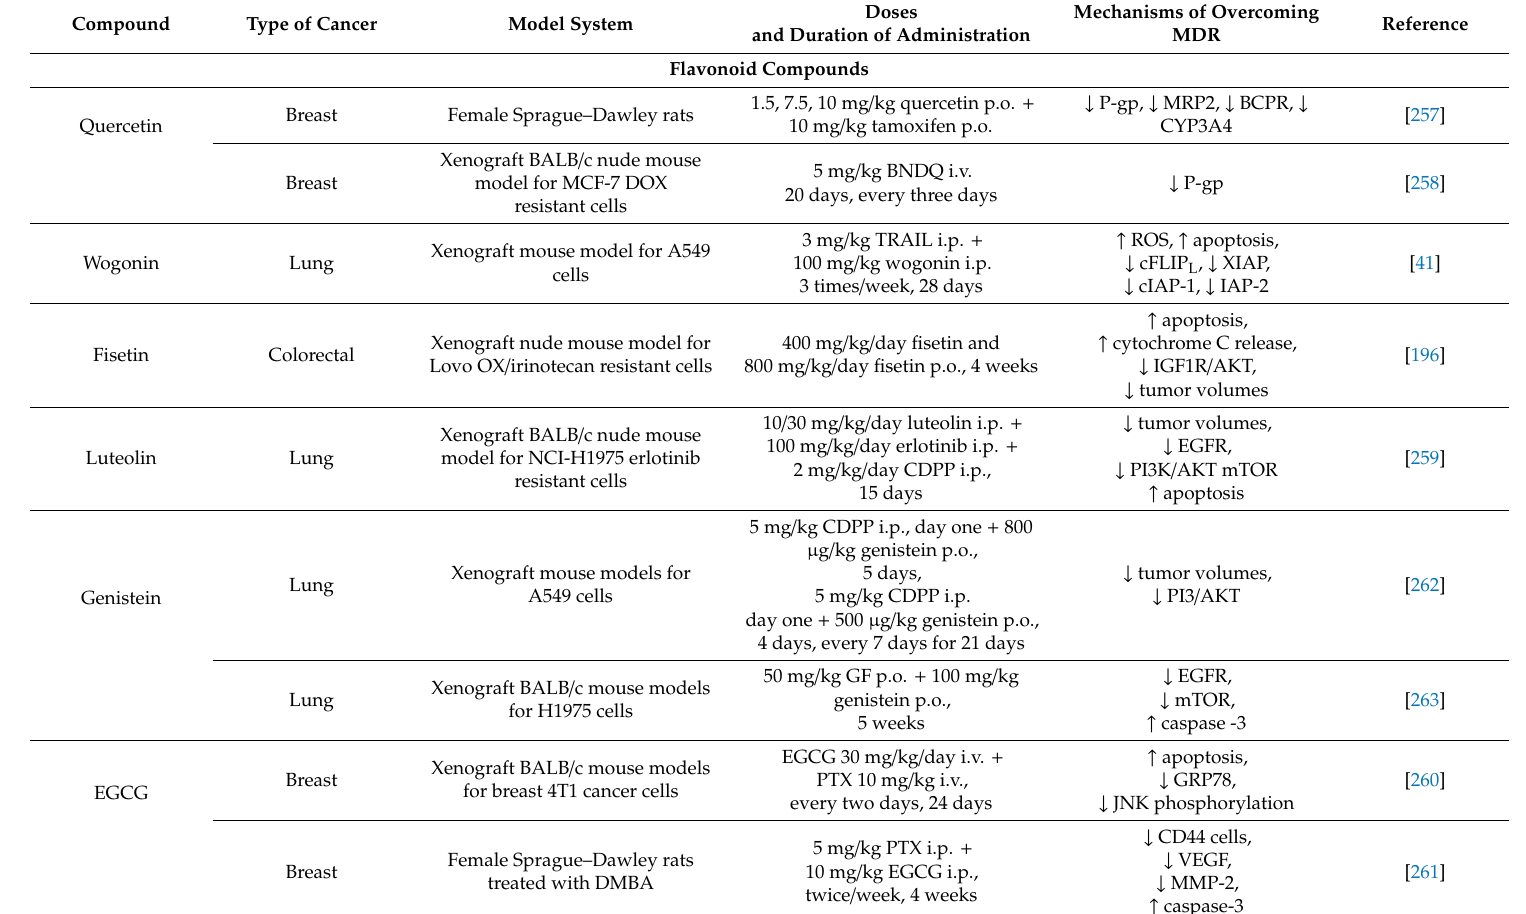
Table 3. Summary of in vivo and clinical